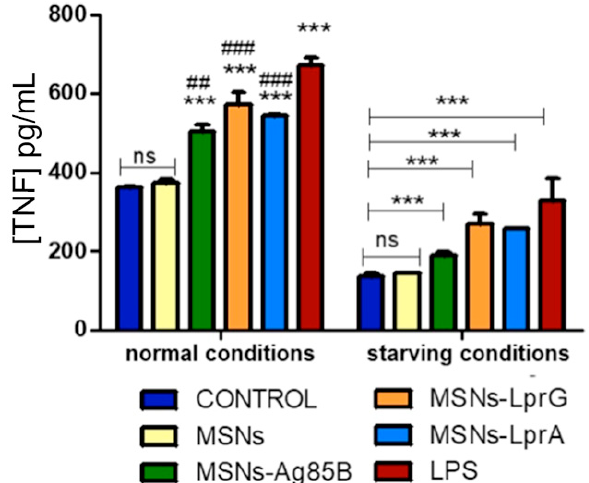
Figure 6. TNF levels after exposure of RAW 264.7 cells to 10 μ g/mL of MSNs, MSNs-Ag85B, MSNs-LprG, or MSNs-LprA for 24 h ( n = 3). Cells treated with lipopolysaccharide (LPS) (100 ng/mL) were used as a positive control. Data were evaluated by ANOVA followed by Bonferroni´s multiple-comparison test. *** p < 0.001 versus control; ## p < 0.005 and ### p < 0.001 versus cells treated with MSNs; ns, not significant.